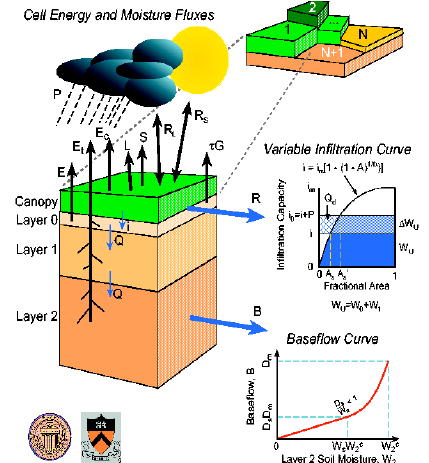
Figure 1. Schematic structure of the Variable Infiltration Capacity (VIC) model (courtesy from https://www.hydro.washington.edu/Lettenmaier/Models/VIC/ ).